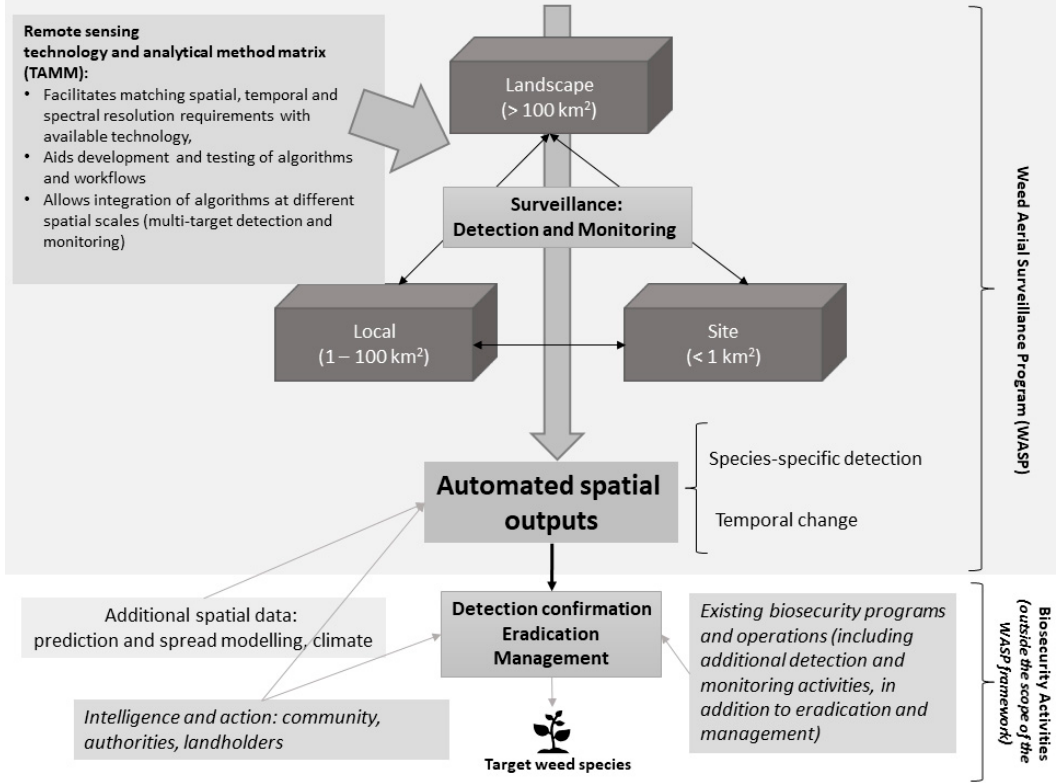
Figure 2. Outline of the Weed Aerial Surveillance Program (WASP) framework, incorporating a remote sensing approach development matrix (TAMM, Table 3). Core components of the WASP framework are highlighted against the light grey background.